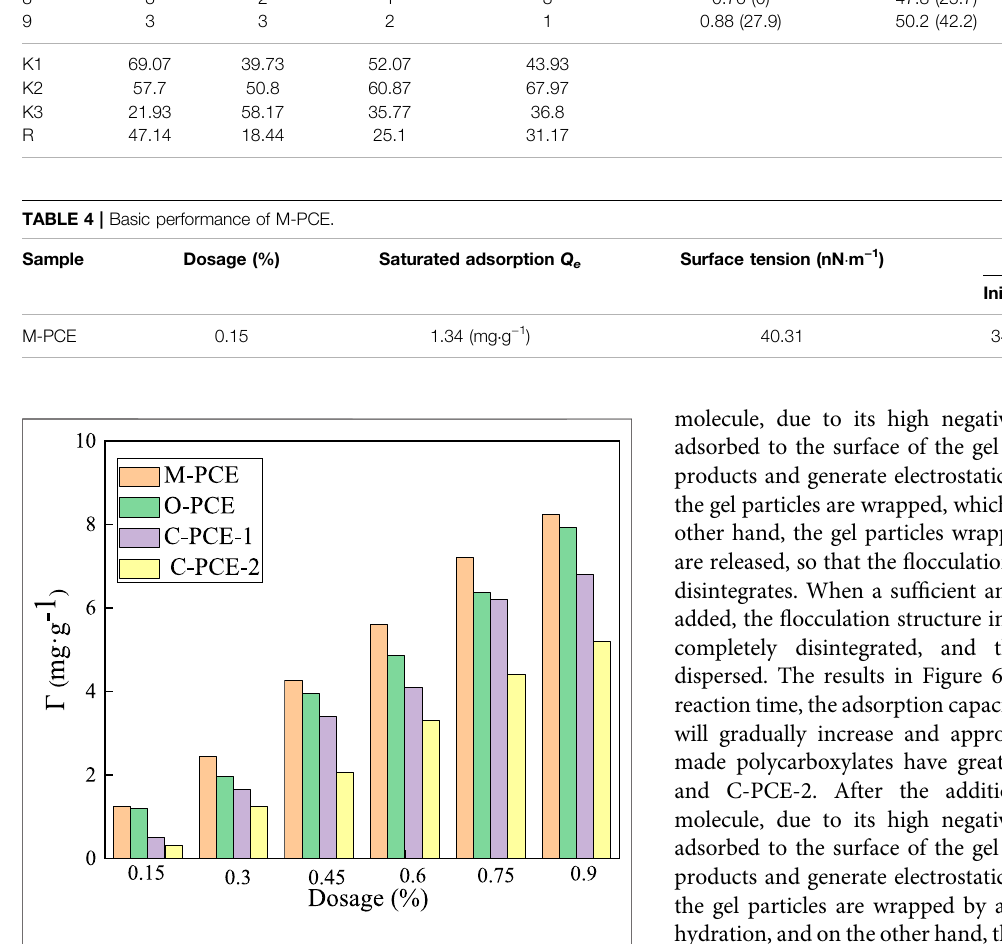
FIGURE 5 | Adsorbed amount of polycarboxylate molecules on the surface of Portland cement surface at different dosages (20 ° C).